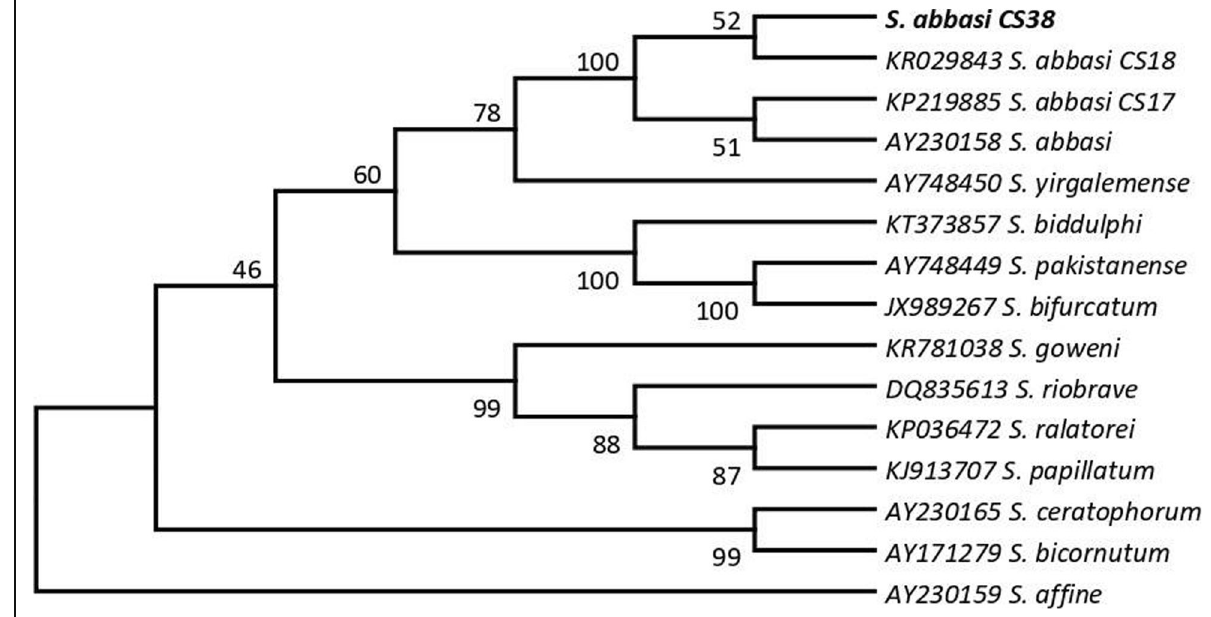
Fig. 2 Phylogenetic relationships in the “ bicornatum ” group of Steinernema based on analysis of ITS rDNA regions. Steinernema affine were used as outgroup taxa. The percentage of replicate trees in which the associated taxa clustered together in the bootstrap test (10,000 replicates) is shown next to the branches. Branch lengths indicate evolutionary distances and are expressed in the units of number of base differences per site